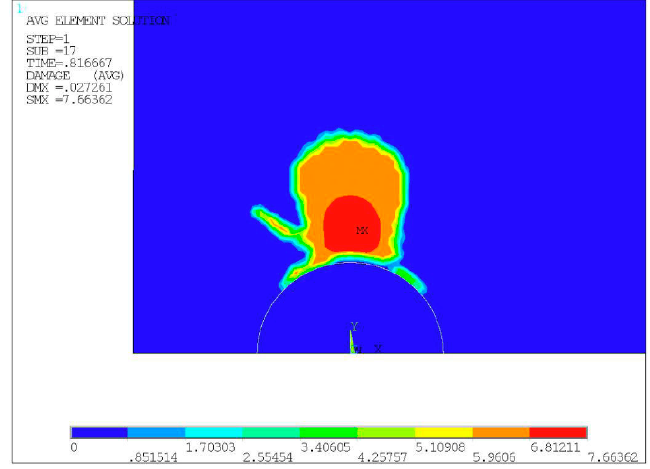
Figure 5. Damage cloud chart of specimen No. 1. Table 2. Experimental Data of Specimen No. 2.